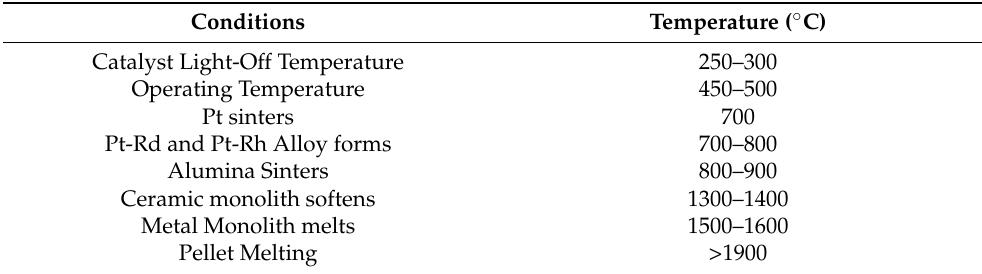
Table 2. Summary of temperature ranges for a specific condition in a catalytic converter. Adapted from [37,48–50]. Conditions Catalyst Light-Off Temperature